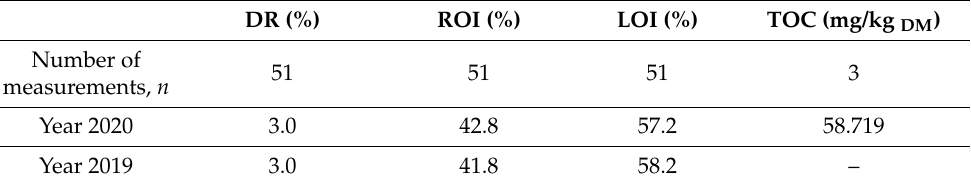
Table 2. Content of total organic carbon (TOC) in digested sludge from Kujawy, dry residue (DR), residue on ignition (ROI), and loss on ignition (LOI); arithmetic mean of n = 51 measurements over 2